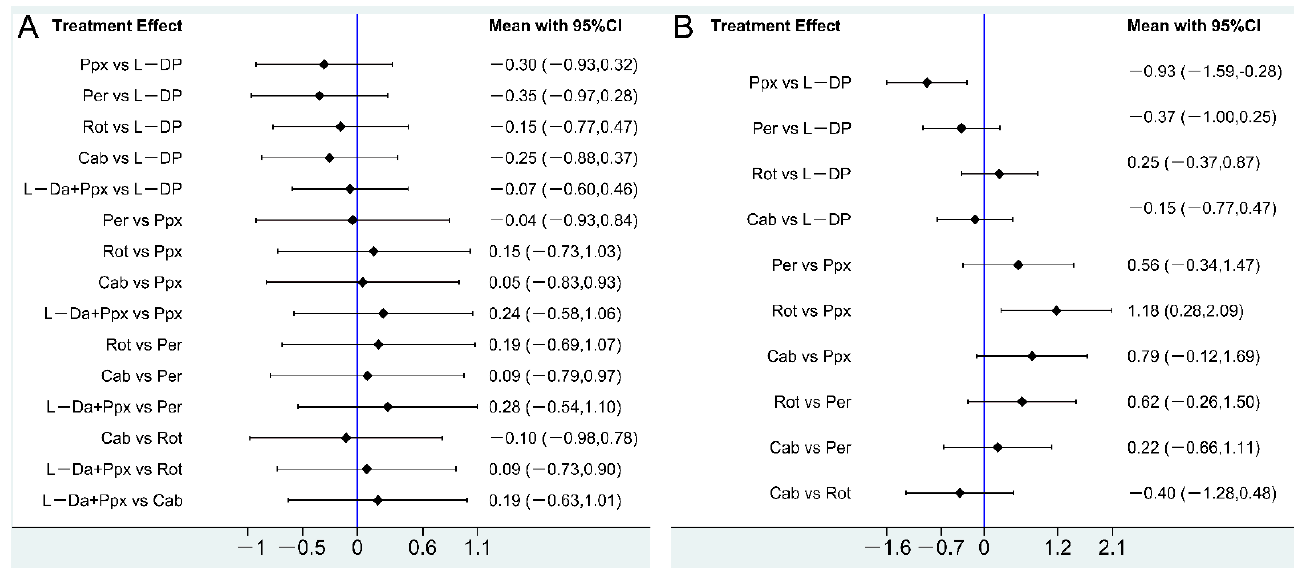
Figure 2. Evidence network diagram of this network meta-analysis. ( A ) Evidence network diagram of letter fluency with rasagiline; ( B ) evidence network diagram of letter fluency without rasagiline; ( C ) evidence network diagram of semantic fluency with rasagiline; ( D ) evidence network diagram of semantic fluency without rasagiline. Because rasagiline did not present connection with other drug regimens, it was excluded from this NMA. Each spot indicates a drug regimen, the size of spot indicates the total number of participants, and each line indicates a comparison between the con- nected drug regimens.